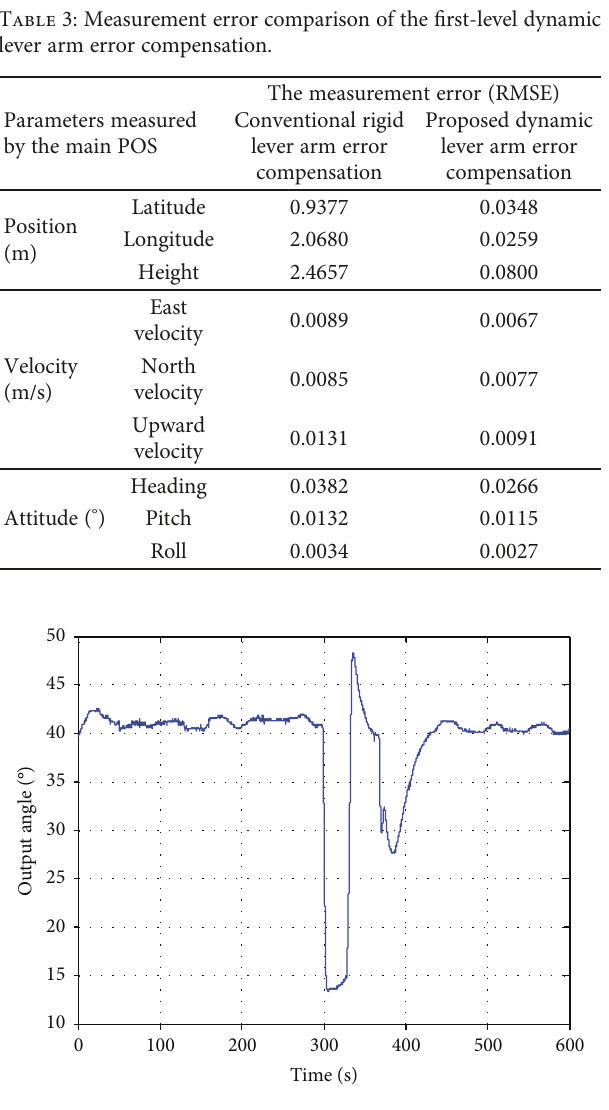
Figure 10: The output angles of the photoelectric encoder used in the experiment system in Figure